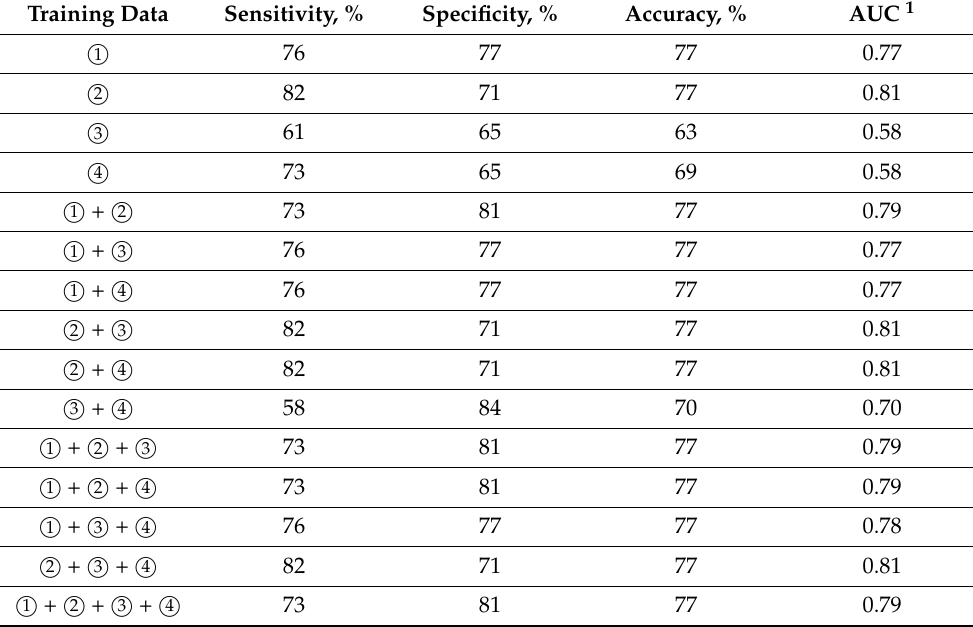
Table 4. Classification results of indices of training data described in Table